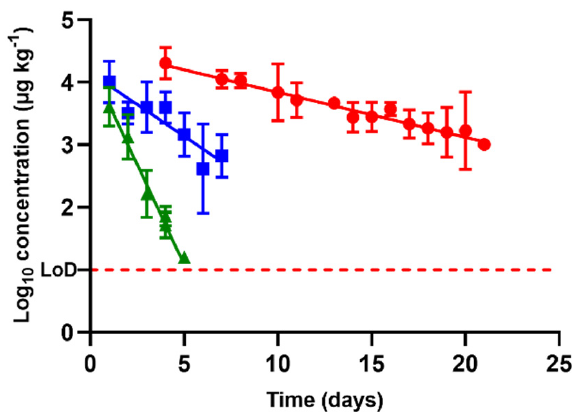
This circumstance, along with the slowest rate of removal described in this study (half-life of 4.18 days, Table 1), indicates that this compound might be a problematic antibacterial residue in terms of farm waste management.